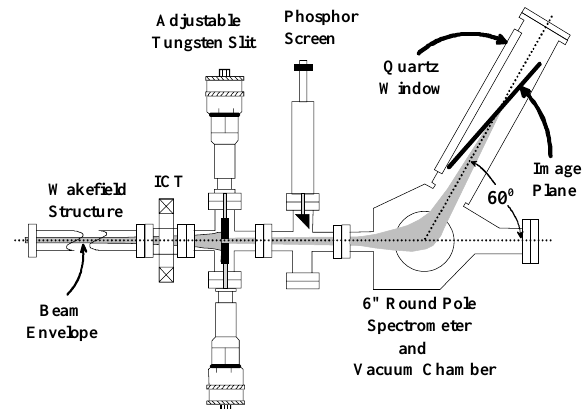
FIG. 6. Energy measurement system. The decelerated drive bunch train passes through a tungsten slit of adjustable width, which is imaged through a 60 ± dipole (diameter (cid:1) 6 00 ) onto a phosphor screen located at the image plane. The phosphor screen is viewed with an intensified camera through the quartz